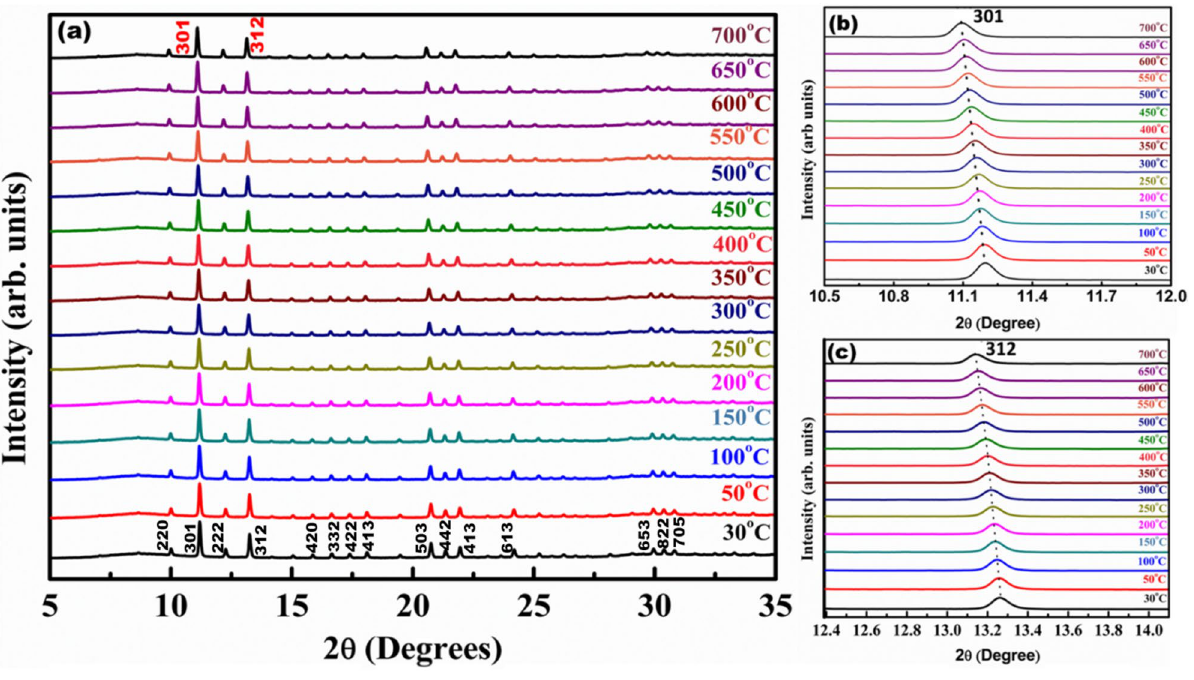
Figure 6. ( a ) Temperature dependent XRD patterns of BFO from 30 °C to 700 °C ( b , c ) shift in 2θ with respect to temperature.